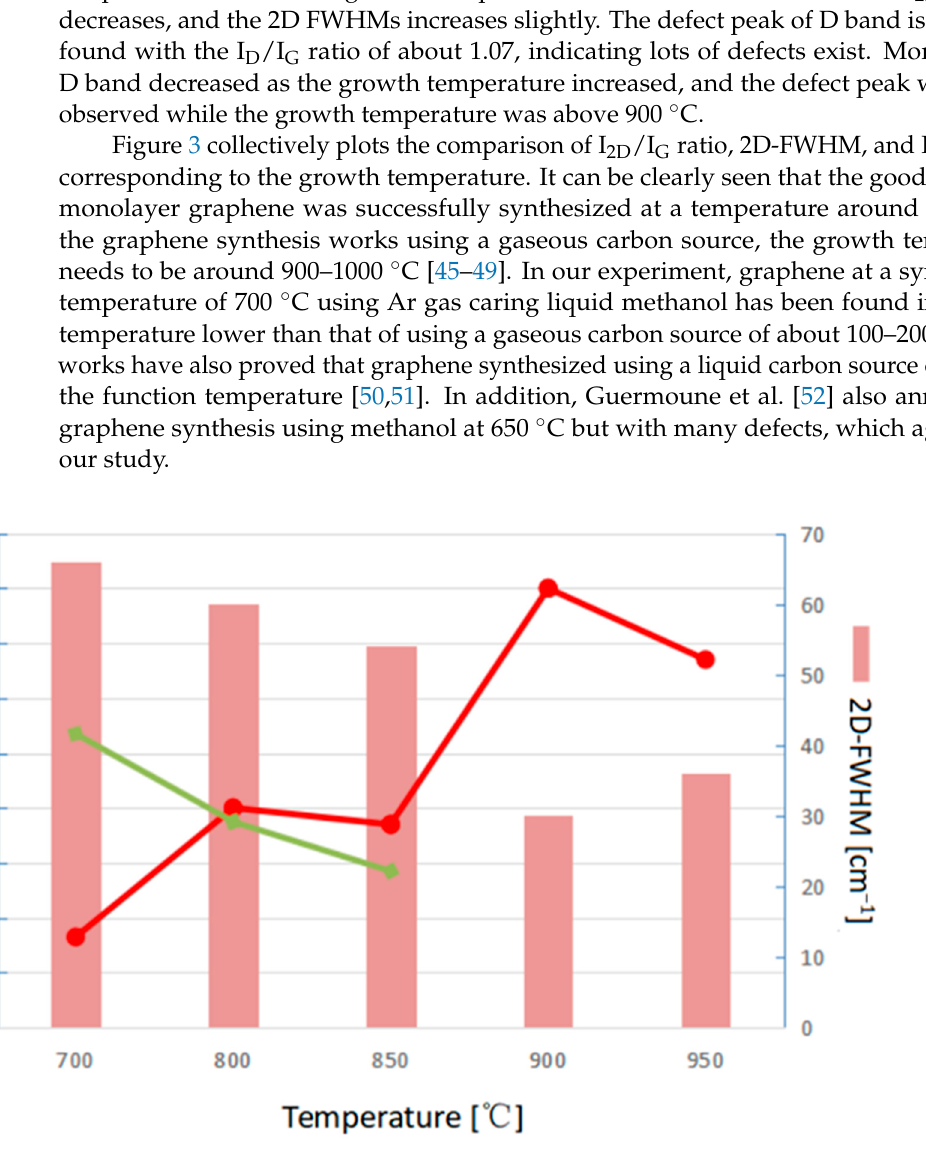
Figure 3. The comparation of I 2D /I G ratio, 2D-FWHM value, and I D /I G ratio of Raman pattern corresponding to the growth temperature.